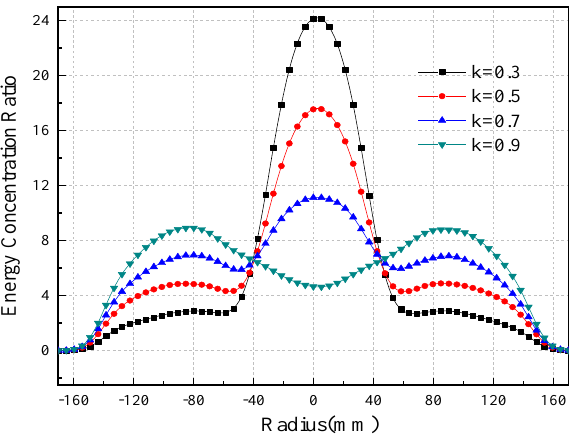
Figure 13. Radial heat flux distributions with different PVR occupation ratios.